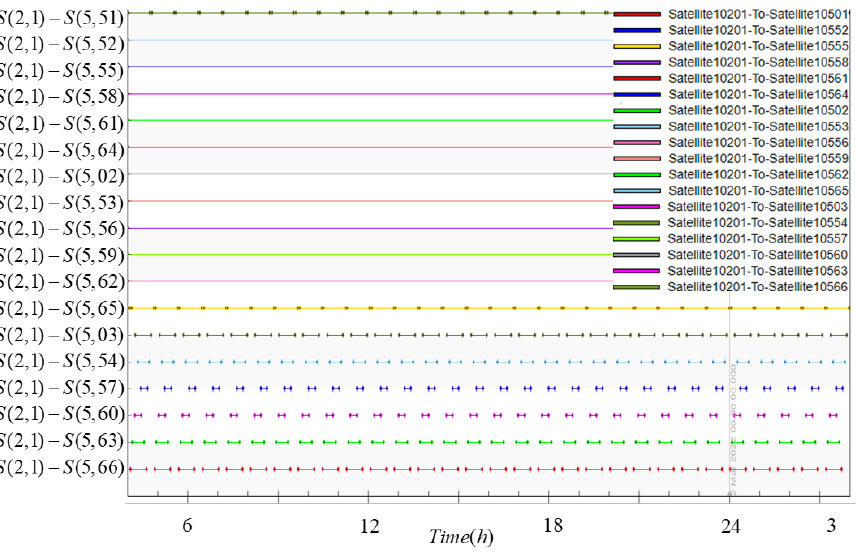
Figure 11. Visibility analysis of neighboring non-adjacent orbiting satellites.